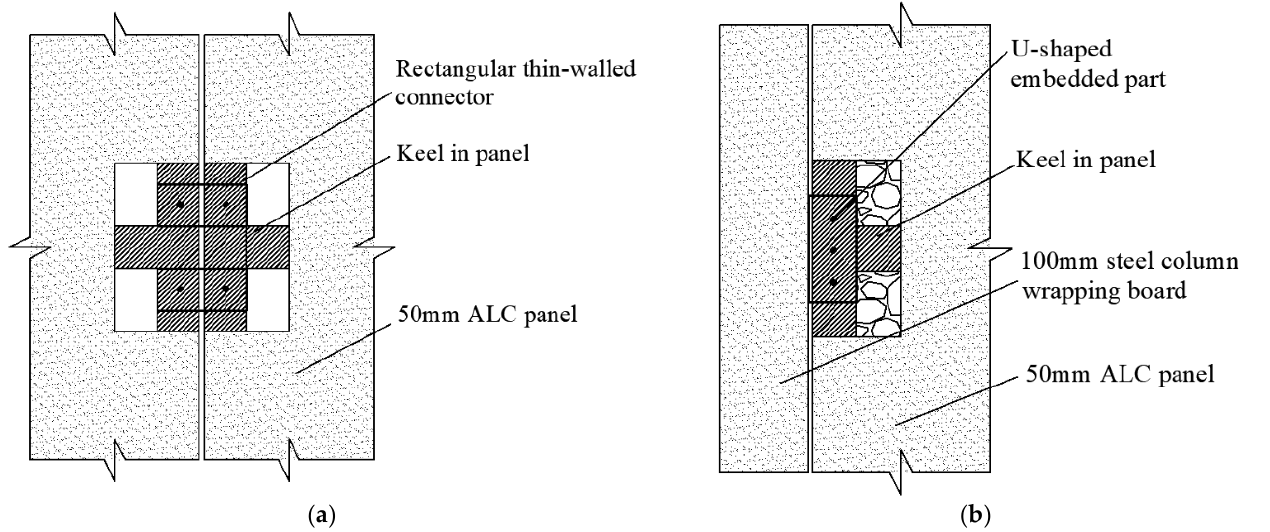
Figure 5. Connections between the parts: ( a ) between sandwich panels; ( b ) between sandwich wall panels and the beam (column).